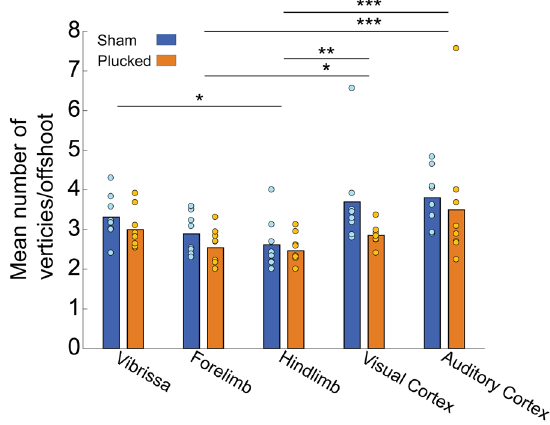
Figure 5. Quantification of network topology with a vertex-per-offshoot metric. Offshoot branches are vascular segments that emerge from the main backbone of the pial network (i.e. the portion that remains on the pial surface) and lead to penetrating arteries. For each such branch, we count the number of vertices (either a bifurcation or a penetrating artery). Plot of the mean vertex/offshoot ratio across cortical area. Bars show means, circles are individual animals. There was no effect of deprivation on the vertex/offshoot ratio, but the hindlimb area had a lower ratio than the vibrissa, visual and auditory cortex. The forelimb area had a significantly lower ratio than visual and auditory cortex. * p < 0.05; ** p < 0.01; *** p <